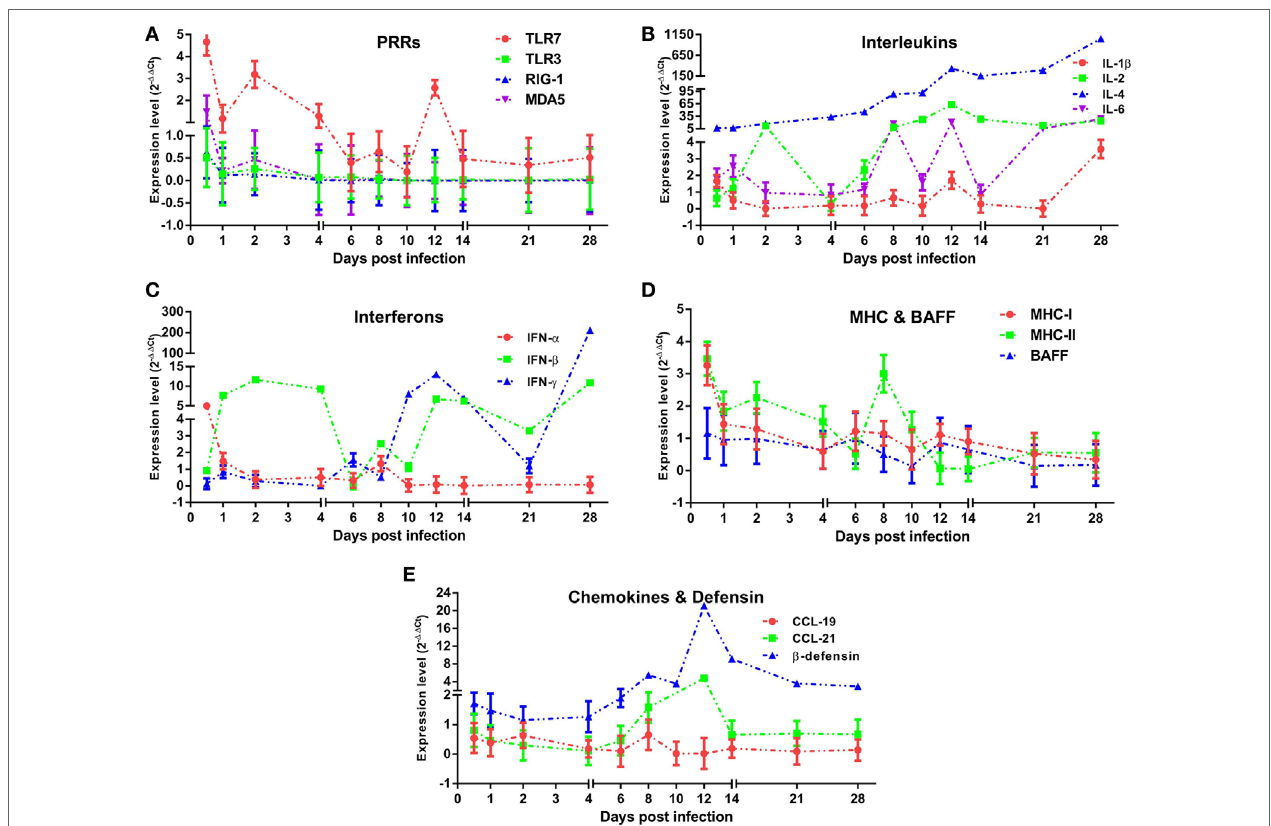
FigUre 3 | Innate immune responses induced in mature ducks by duck hepatitis A virus 1 infection in the blood. Expression levels of immune-related genes were calculated by the 2 −ΔΔ Ct method using 1 as the baseline. The changes of PRRs (a) , Interleukins (B) , Interferons (c) , MHCs and BAFF (D) , and CCLs and β -defensin (e) within 1 month post-infection were